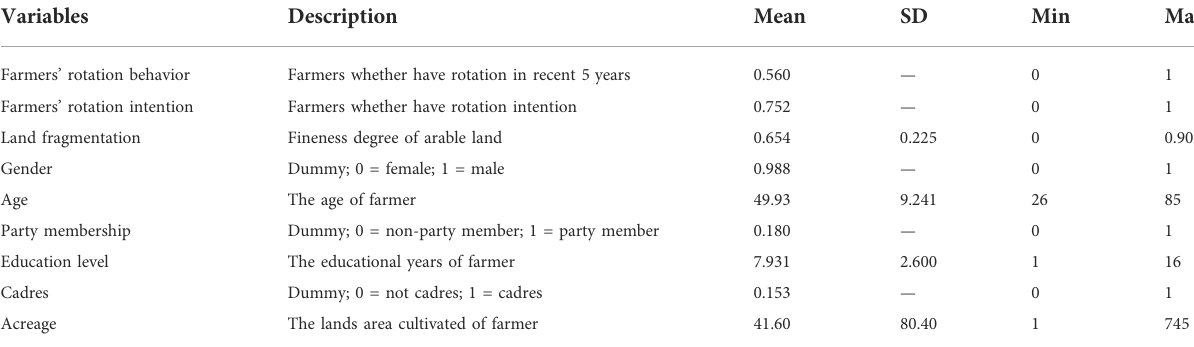
TABLE 1 De fi nitions of